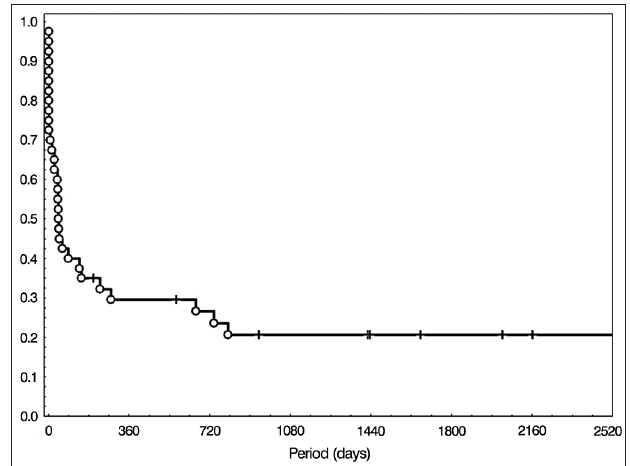
Figure 3. Disease-free survival in the group treated with radiotherapy and chemotherapy.